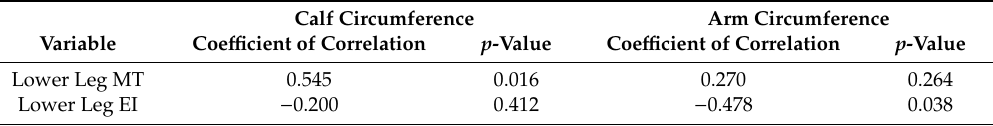
Table 2. Correlations between muscle ultrasound variables and nutritional parameters.